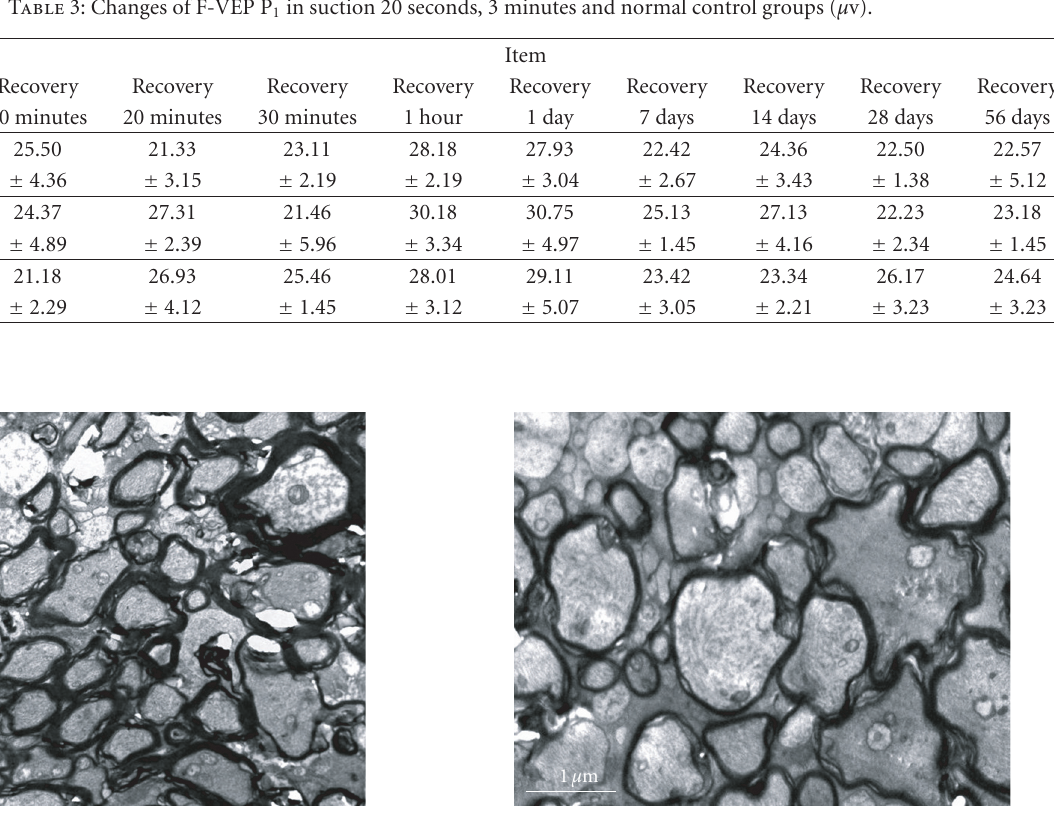
Figure 6: Shortly after suction 3 minutes, optic nerve fiber marrow scabbard is turbulence, canaliculus and tiny threads are no clear ( ×